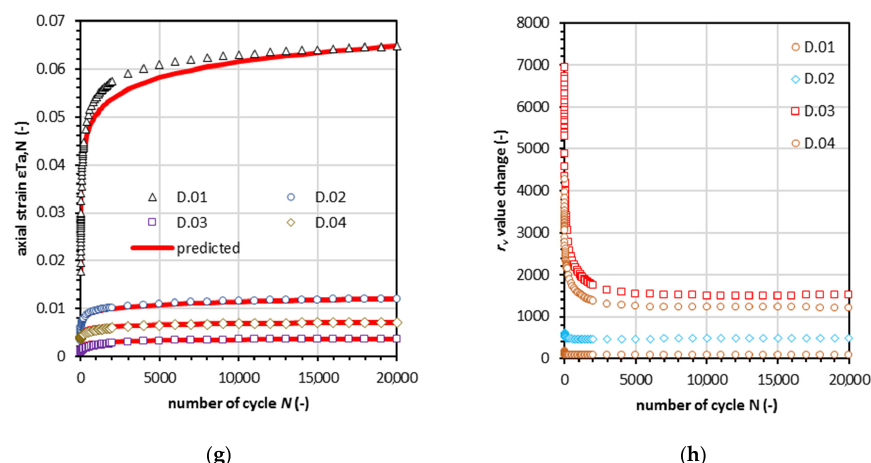
Figure A1. The Axial strain test results with the prediction based on the resistance concept and the abation number r v characteristics: ( a ) axial strain development and prediction for soil Type A, ( b ) r v value versus number of cycles for soil Type A, ( c ) axial strain development and prediction for soil Type B, ( d ) r v value versus number of cycles for soil Type B, ( e ) axial strain development and prediction for soil Type C, ( f ) r v value versus number of cycles for soil Type C, ( g ) axial strain development and prediction for soil Type D, ( h ) r v value versus number of cycles for soil Type D.